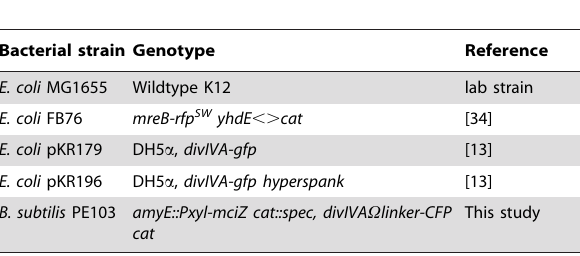
Table 1. List of bacterial strains used in this